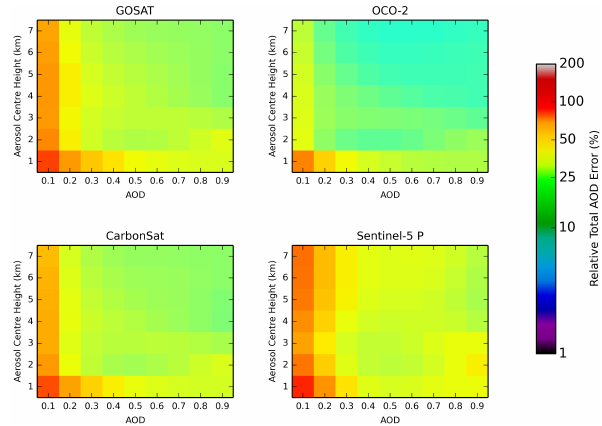
Figure 8. Total AOD error (given as a relative error) as a function of aerosol centre height and AOD for the four instruments for a SZA of 30 ◦ and albedo of 0.5. Intensity offset is included in the